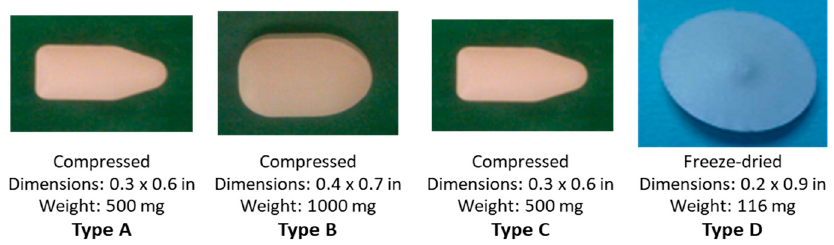
Figure 4. Placebo vaginal inserts tested in CONRAD Study D15-134 [32].